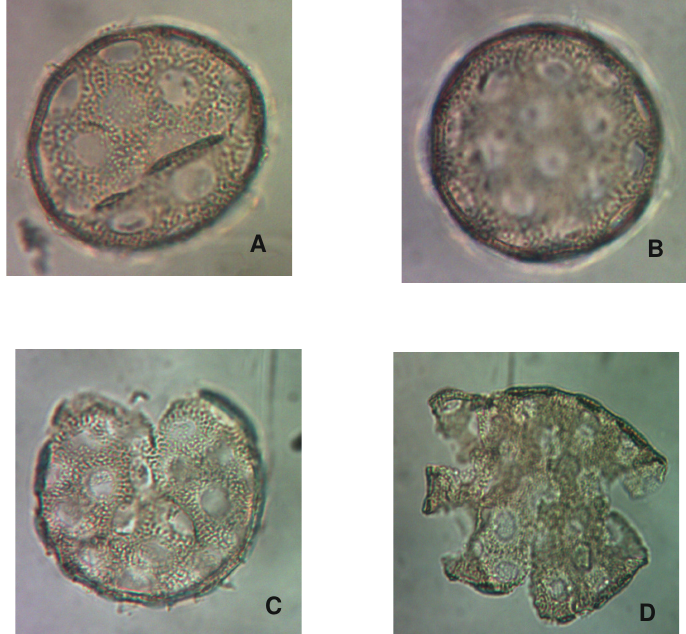
Fig. 5. Pollen grains of T . triangulare pink petals (×400) A & B. Acolpate, C. Monocolpate, D.